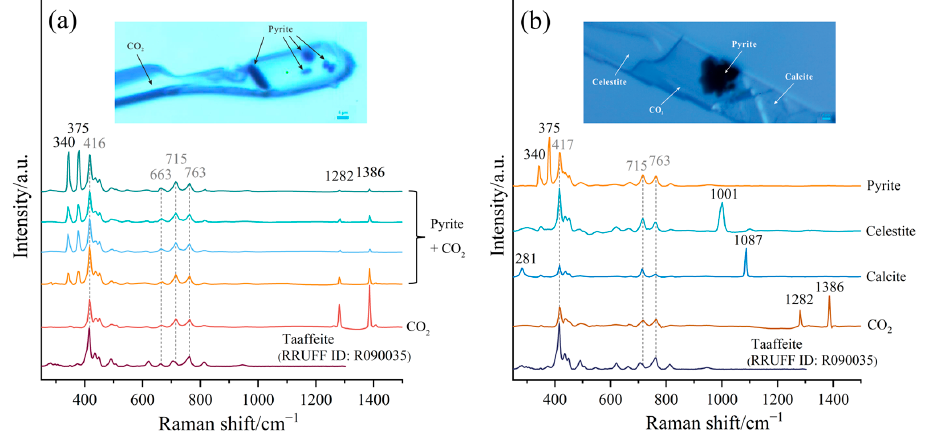
Figure 6. ( a ) and ( b ) Two multi-phase inclusions in sample 2 and their corresponding Raman spectra (the numbers marked as gray are the Raman peaks of the host taaffeite).